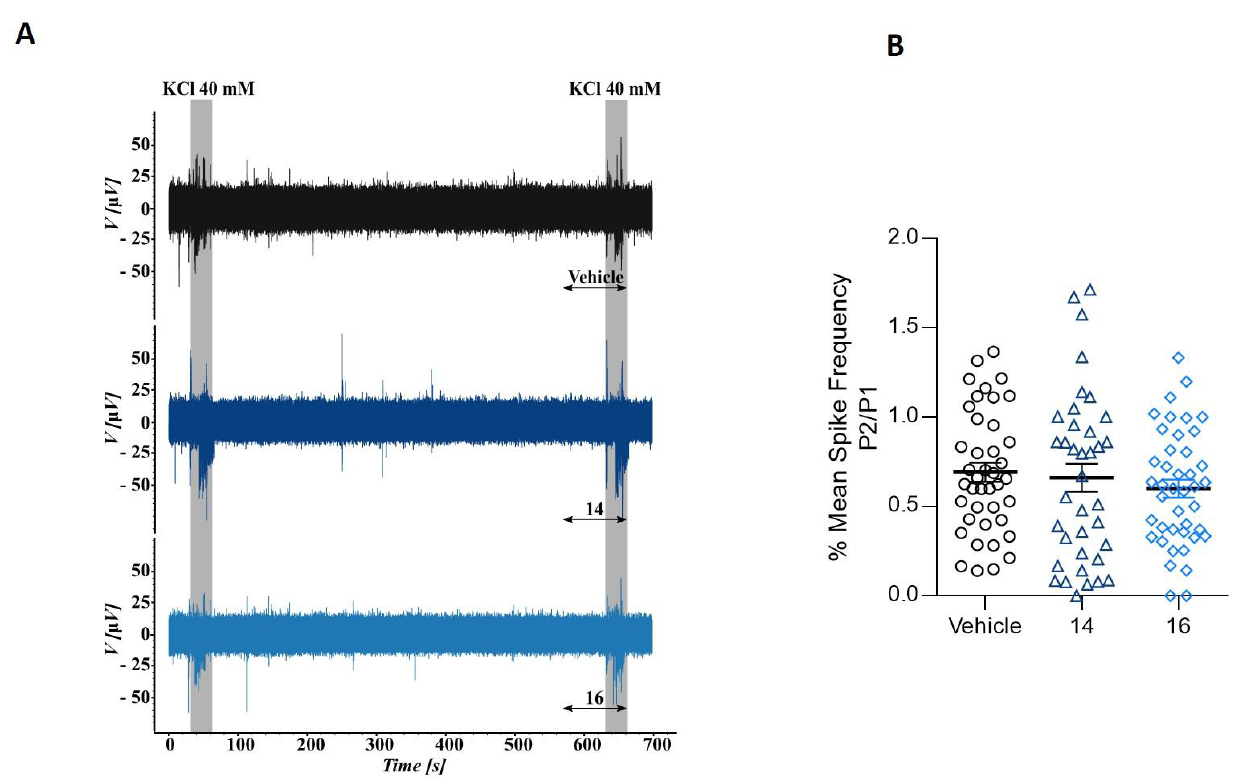
Figure 4. Compounds 14 and 16 do not alter potassium-evoked action potentials in primary cultures of rat sensory neurons. ( A ) Representative recordings of evoked action potentials in rat DRG neurons with 40 mM KCl (K) in the absence (top) and presence of 10 μ M compound 14 (medium trace) or 10 μ M compound 16 (bottom trace). ( B ) Mean spike frequency measured on the first pulse (P1) and second pulse (P2) of 40 mM KCl in absence or presence of 10 μ M compounds.